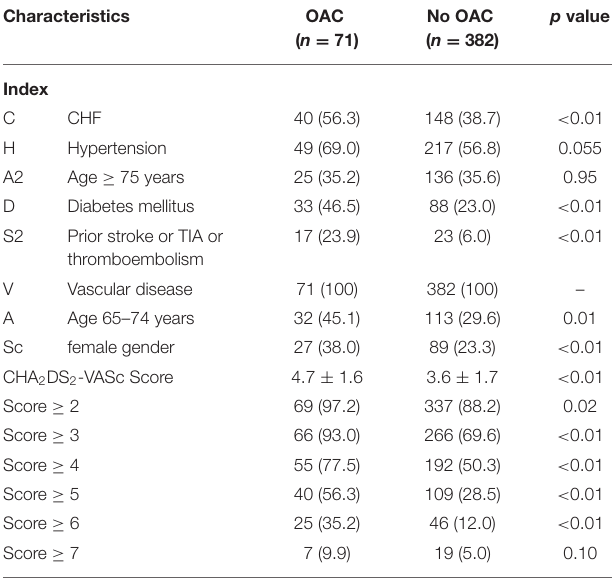
TABLE 4 | Detail information of CHA 2 DS 2 -VASc